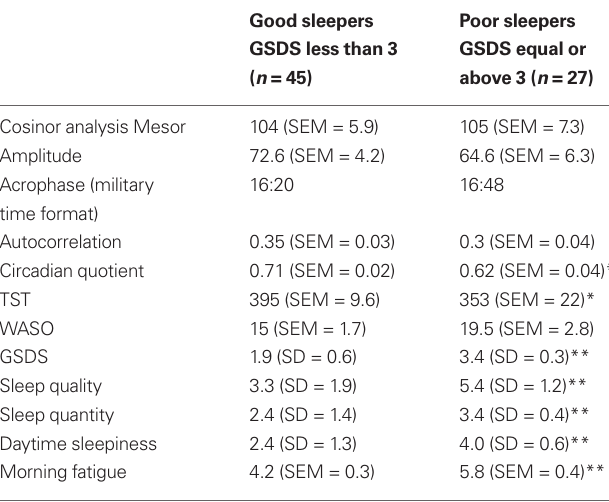
Table 4 | Circadian activity rhythm, sleep, and fatigue characteristics based on